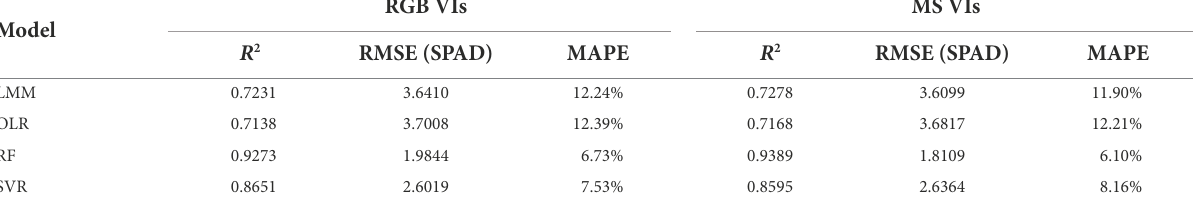
TABLE 8 Evaluation of the LMM, OLR, RF, and SVR models with shade